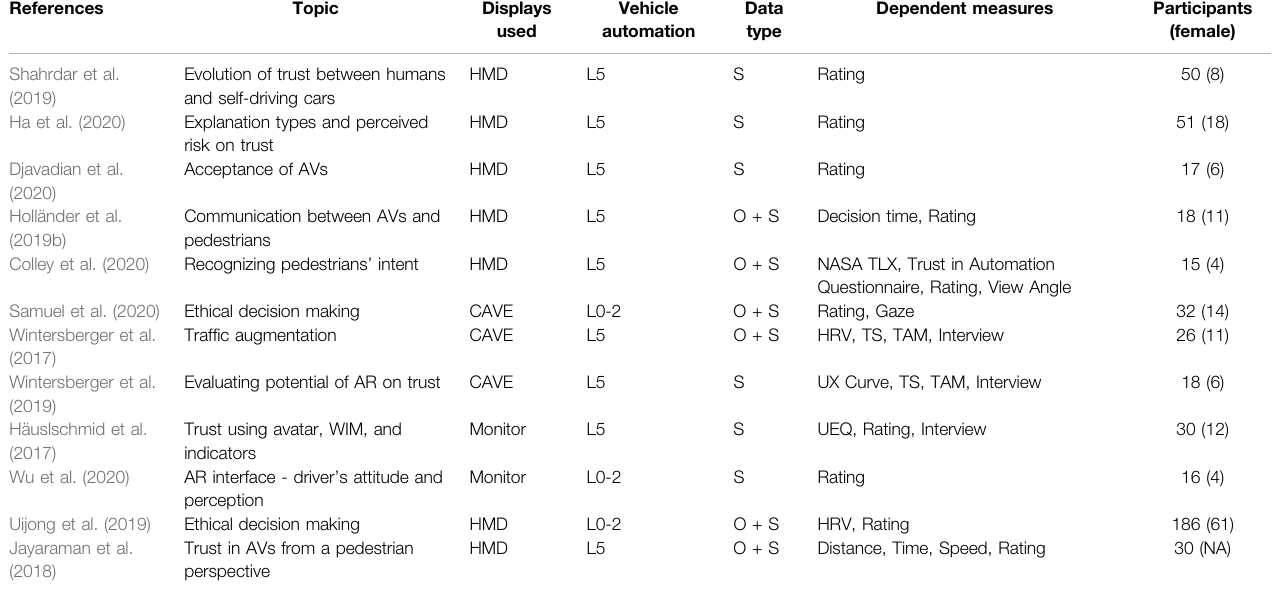
TABLE 11 | Summary of user studies in Trust, Acceptance, and Ethics